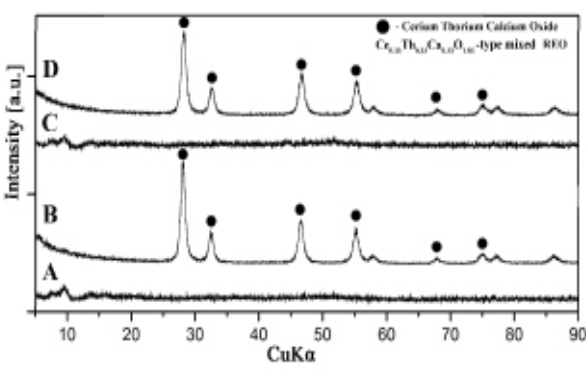
Fig. 2. XRD patterns of the precipitated and calcined samples: (A) - 5 min. magnetic stirred and precipitated, (B) - 700 o C calcined sample of (A), (C) - 60 min. magnetic stirred and precipitated, (D) - 700 o C calcined sample of